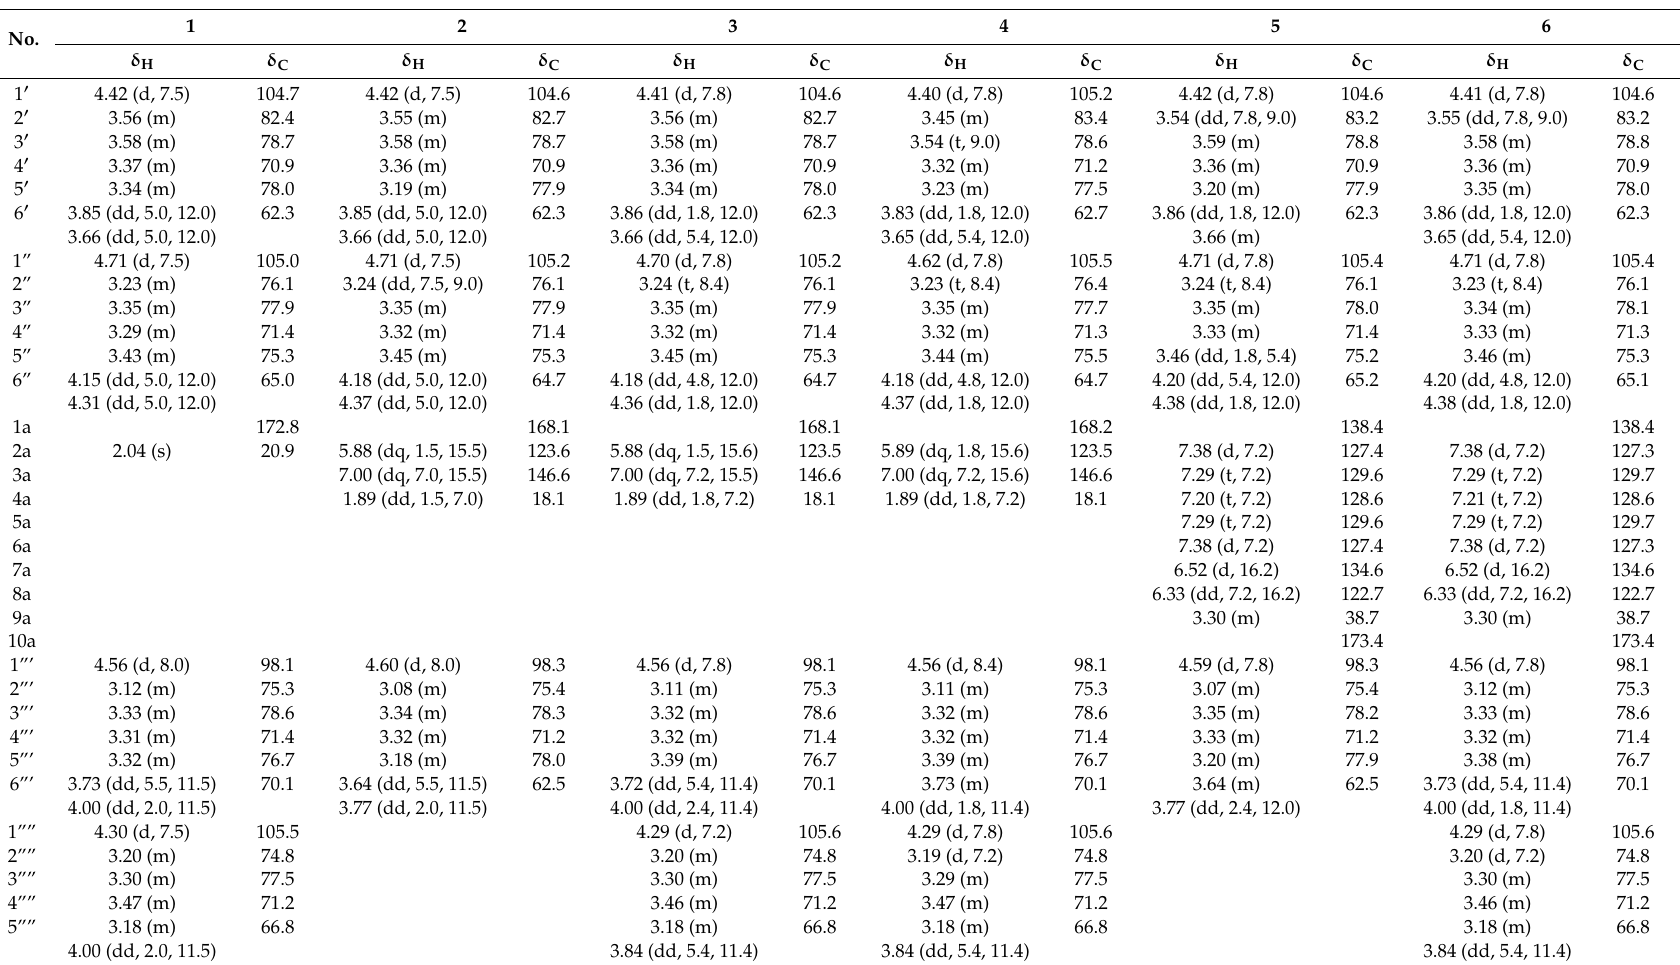
Table 2. 1 H- and 13 C-NMR spectroscopic data of the sugar moieties of gypenosides CP1-6 ( 1 – 6